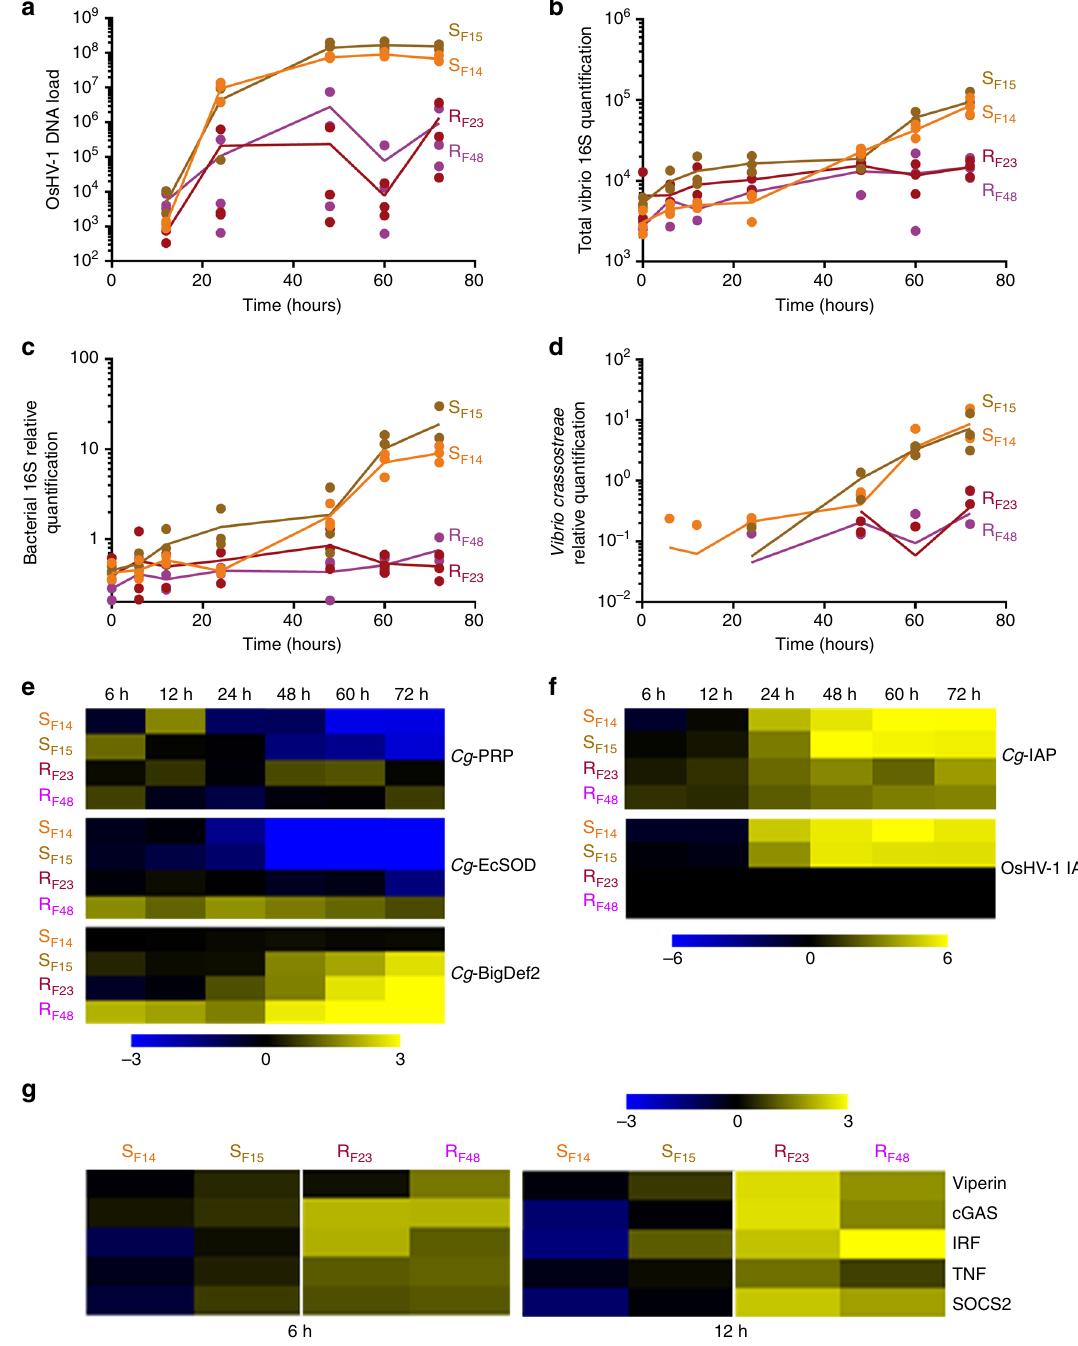
Fig. 9 Conservation of molecular events during the ‘ natural ’ experimental infection in the susceptible S F14 and S F15 , and in the resistant R F23 and R F48 oysters. a The OsHV-1 load was quanti fi ed by qPCR. Quanti fi cation of total Vibrio ( b ), total bacteria ( c ) and Vibrio crassostreae ( d ) were performed by qPCR. For a to d , dots represent distinct pools of 10 oysters. The mean values (plain lines) are displayed. Heatmap of antimicrobial peptide ( Cg -Bigdef2, Cg -PRP), Cg -EcSOD ( e ) and IAPs ( f ) expression measured by RT-qPCR in each oyster family. g Heatmap of antiviral gene (Viperin, cGAS, IRF, TNF and SOCS2) expression measured by RT-qPCR in each oyster family at early time points (6 and 12 h) of the experimental infection. The intensity of the colour from blue to yellow indicates the magnitude of the differential expression (log2 fold change). The heatmap was constructed with Multiple Array Viewer